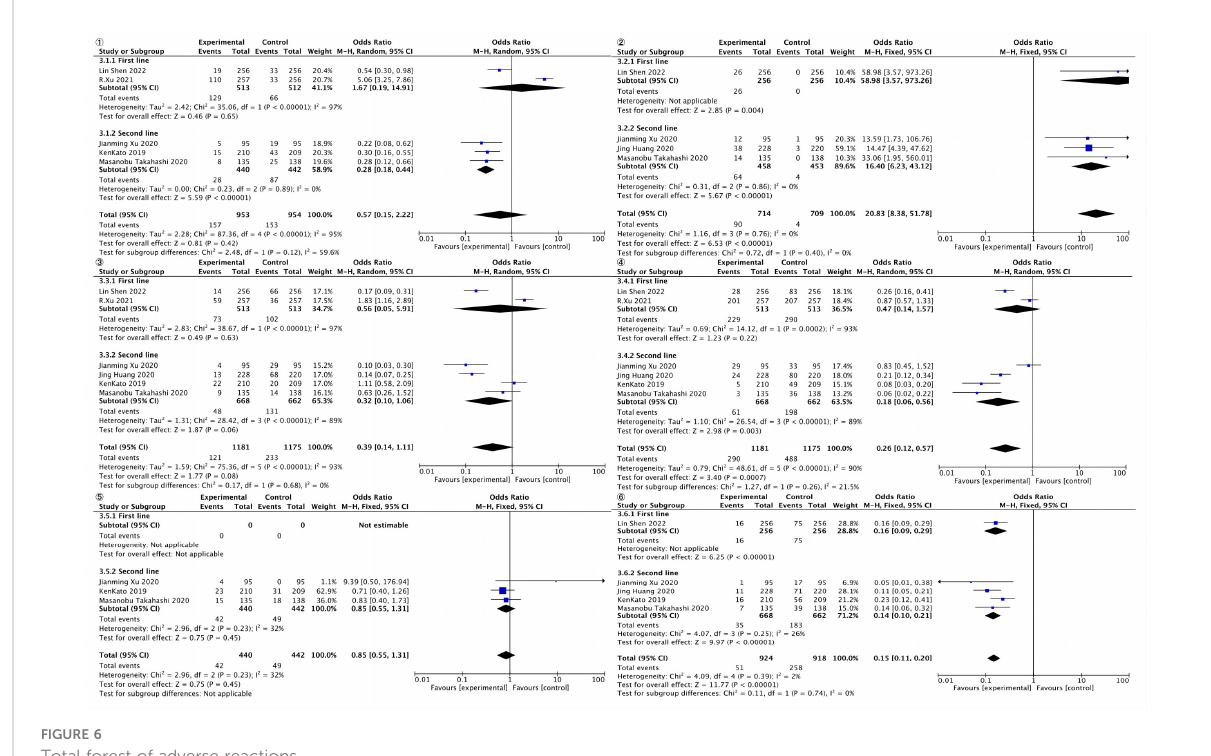
FIGURE 6 Total forest of adverse